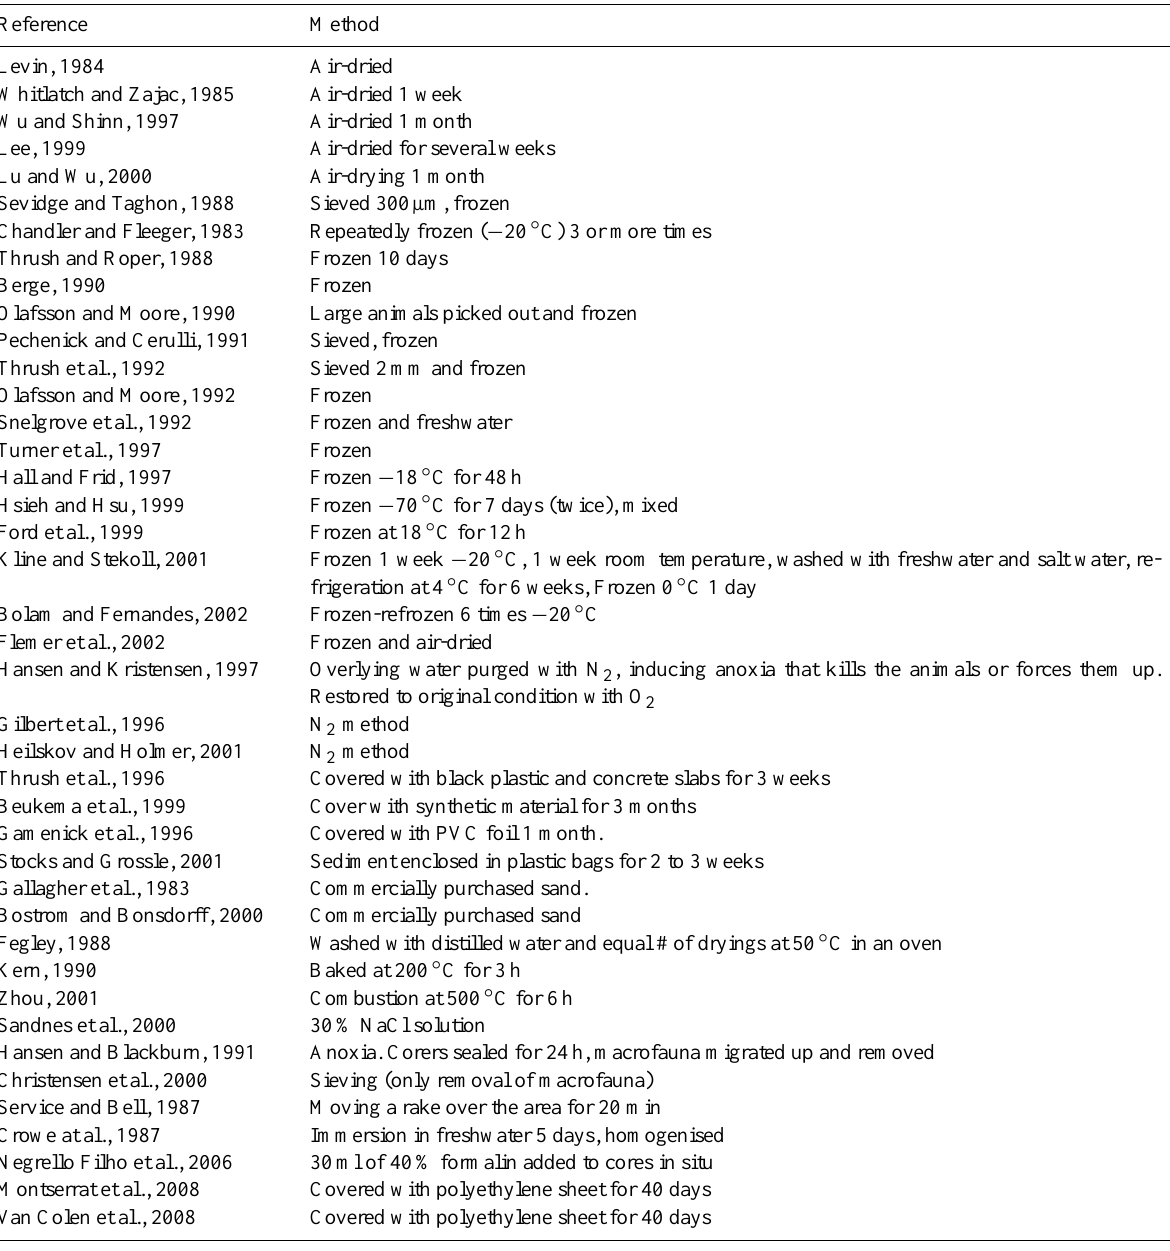
Table 1. Summary of some of the various different approaches used to defaunate sediments; there is no standard methodology even when the same technique is